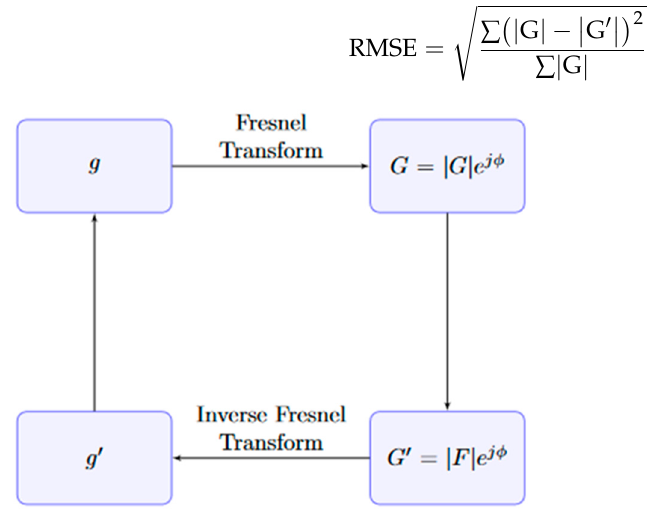
Figure 2. Gerchberg–Saxton algorithm used in the design of the optical element.